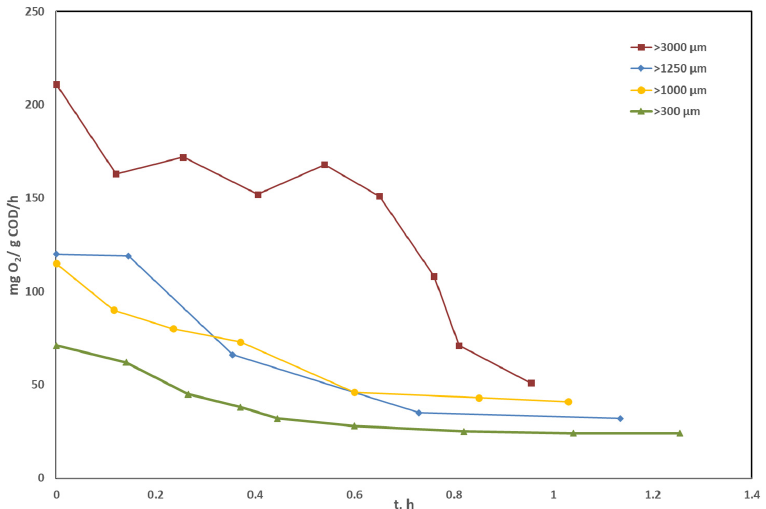
Figure 9. Respirograms corresponding to the specific oxygen uptake rate of aqueous samples collected downstream of sieves with certain opening